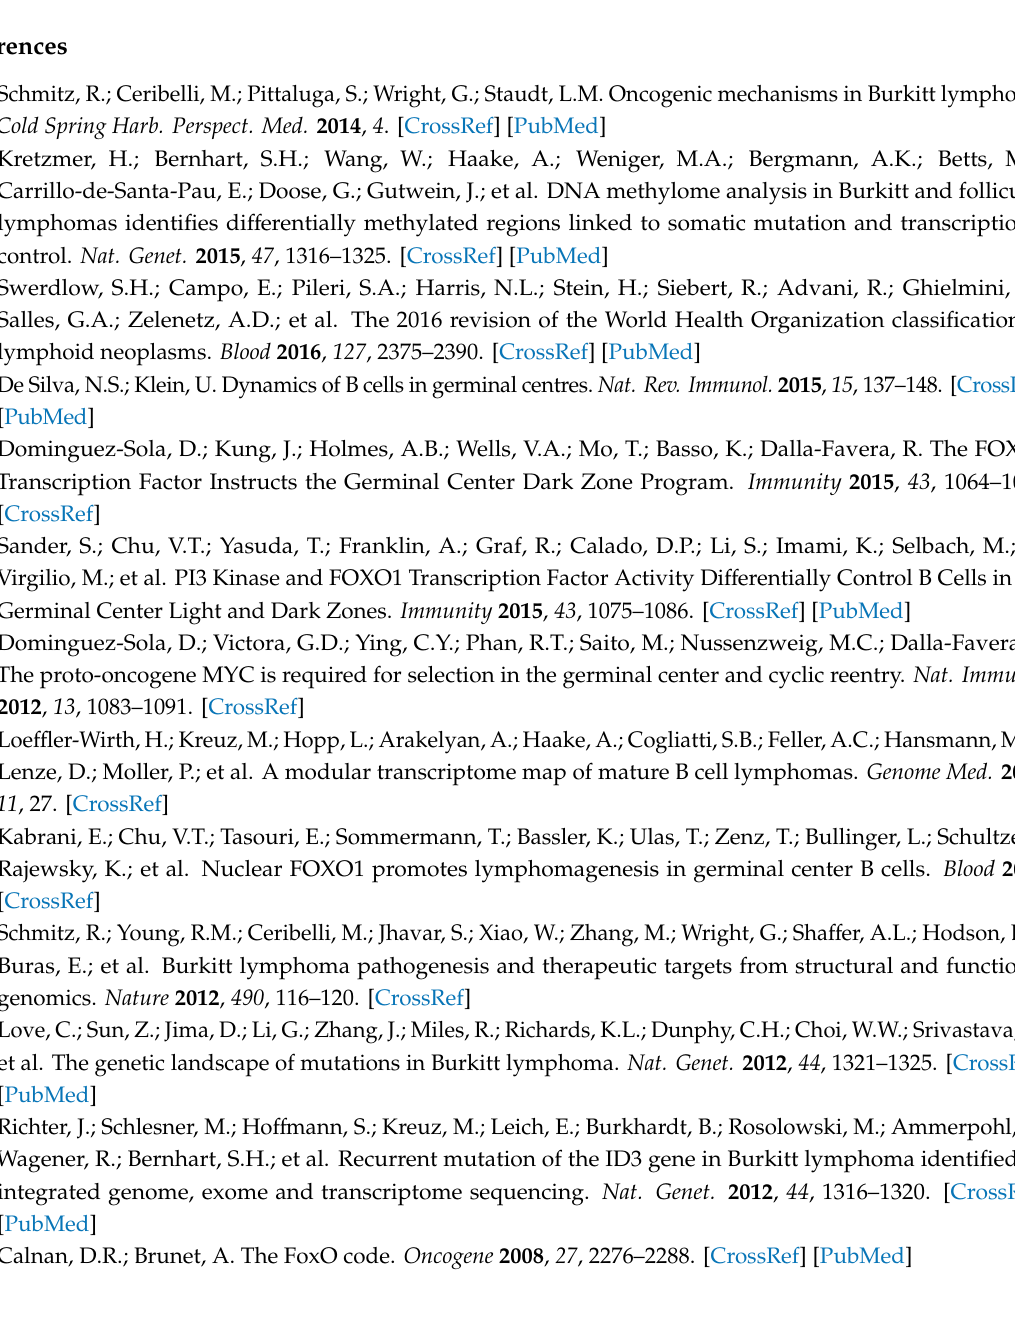
two Burkitt lymphoma cell lines, Table S20: Gene signatures of FOXO1 target genes in human germinal center B cells as well as FOXO1 target genes upregulated in DZ vs. LZ cells or vice versa